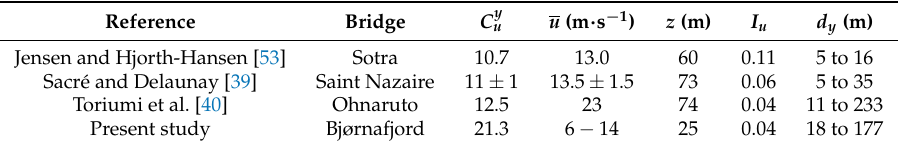
Table 5. Decay coefficients available in the literature, obtained from full-scale measurements of the wind coherence along a suspension bridge crossing a fjord, an estuary or a strait. Reference Bridge C y u